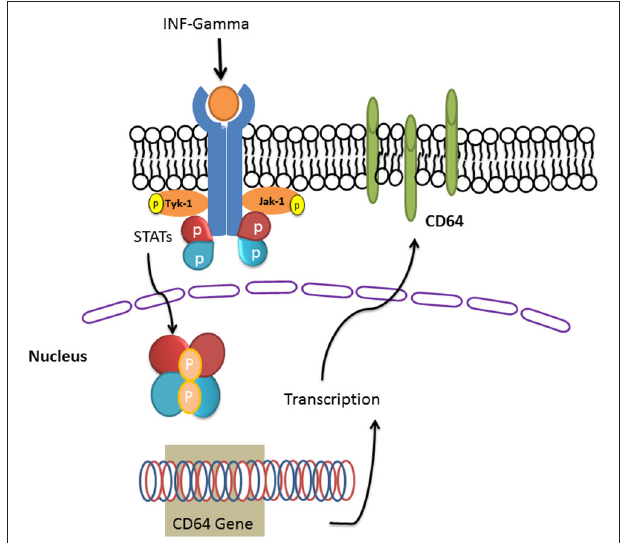
FIGURE 4 | INF-gamma induced the expression of Fc gamma receptor (CD64). IFN- γ induces its receptor and the downstream signaling pathways including JAKs and the STAT family of transcription factors. STAT dimers enhance the transcription of CD64 gene and the translated CD64 will be targeted in to the plasma membrane bilayer